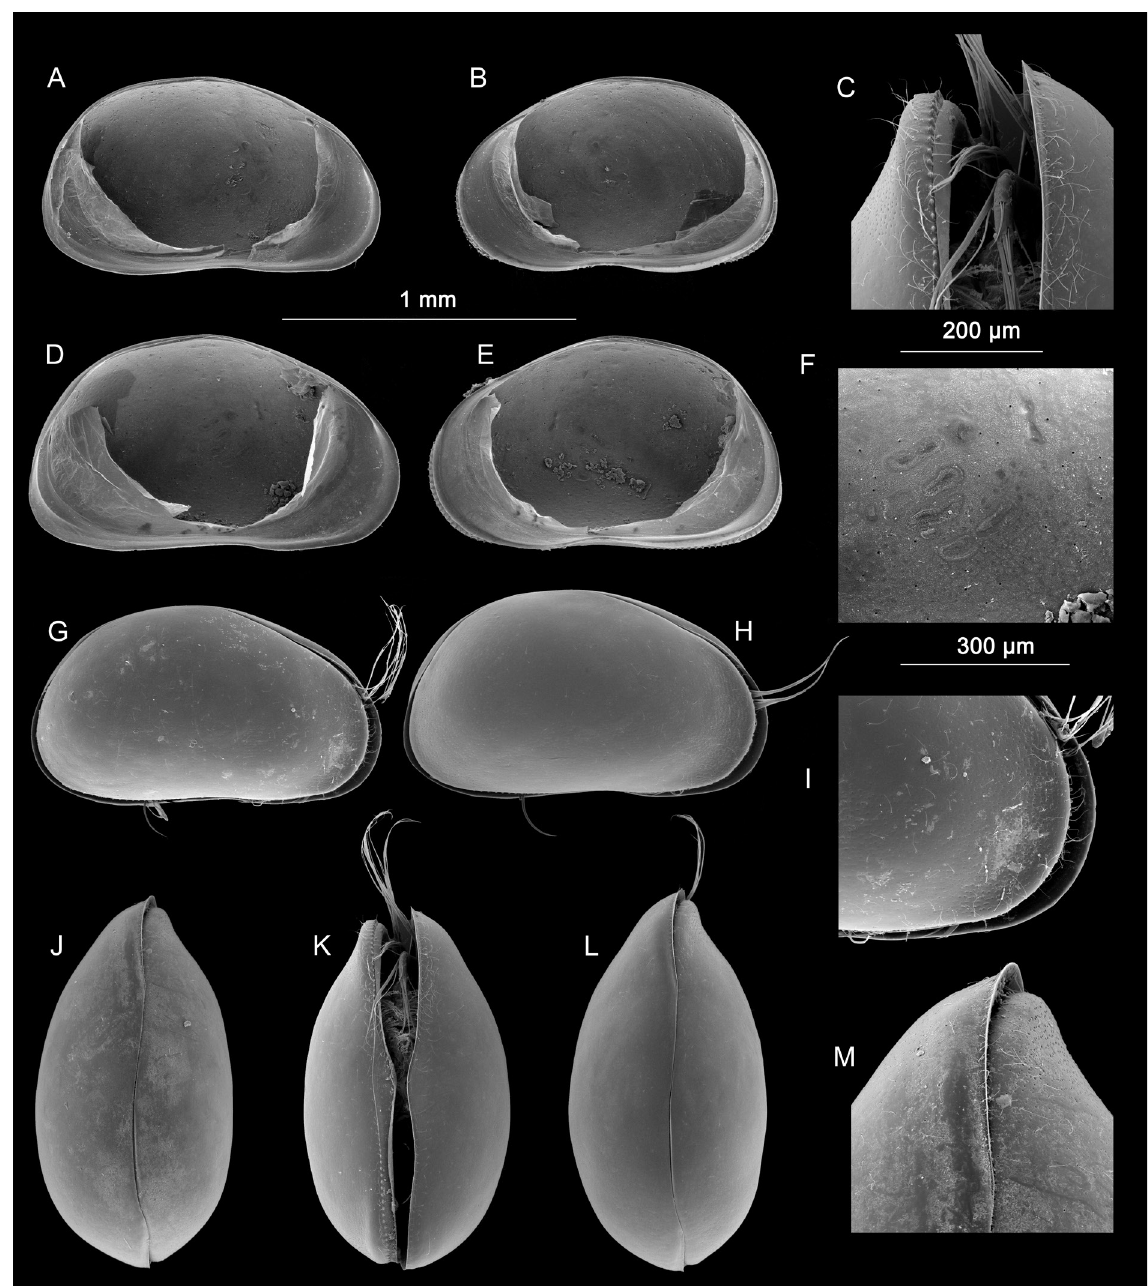
Fig. 8. Bilocypris fortescuensis gen. et sp. nov., Forstescue Marsh (type locality). A . LVi, ♂, holotype (WAM 67205). B . RVi, ♂, holotype (WAM 67205). C . CpV, detail anterior, ♀ (WAM 67216). D . LVi, ♀, allotype (WAM 67206). E . RVi, ♀, allotype (WAM 67206). F . RVi, ♀, detail central muscle scars, allotype (WAM 67206). G . CpRL, ♂ (WAM 67212). H . CpRL, ♀ (WAM 67215). I . CpRL, detail anterior, ♀ (WAM 67212). J . CpD, ♂ (WAM 67213). K . CpV, ♀ (WAM 67216). L . CpD, ♀ (RBINS INV 1380377). M . CpD, detail anterior, ♂ (WAM 67213). Scales: A–B, D–E, G–H, J–L = 1 mm; C, F, M = 200 µm; I = 300